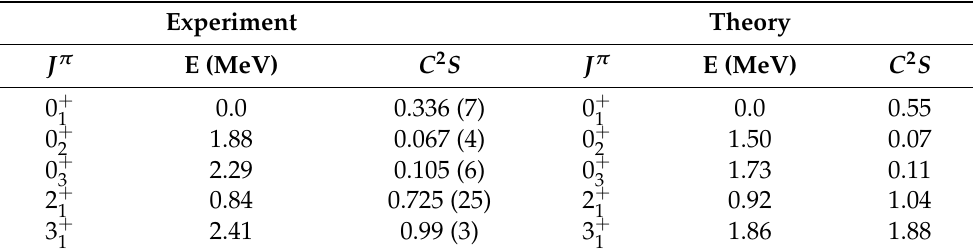
Table 3. Spectroscopic factors in 94 Sr; see the text for more